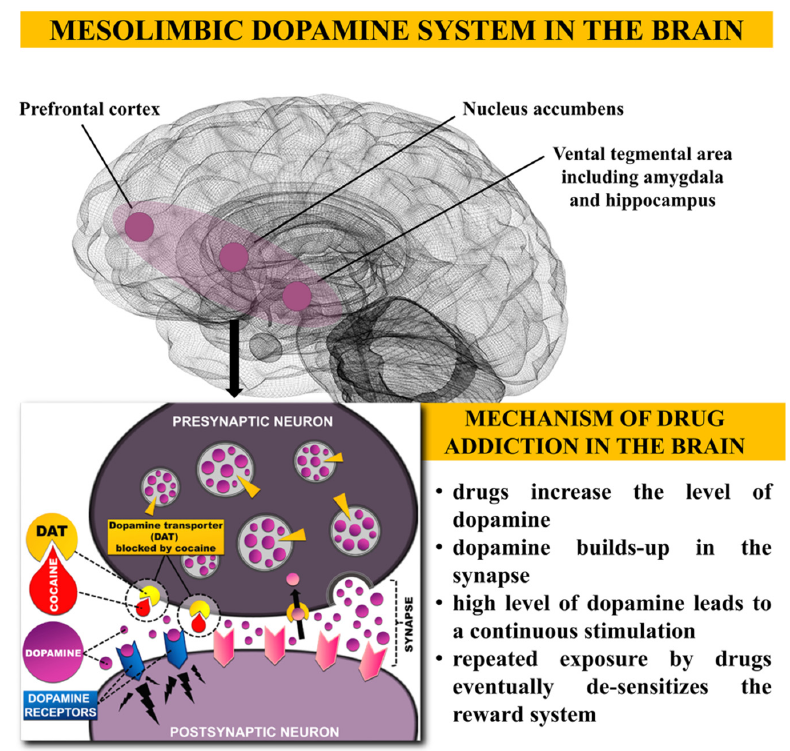
Figure 2. Model of drug addiction mechanism and dopamine projection in mesolimbic dopamine system: dopamine, drugs (stimulants, opioids), dopamine receptors, dopamine transporter (DAT). A schematic diagram illustrates the mesolimbic dopamine system in the brain and the dopamine neuronal role in drug addiction. Dopamine projections target the nucleus accumbens, prefrontal cortex, amygdala, and hippocampus. Direct administration of drugs and their systemic administration results in the release of large amounts of dopamine from dopamine neurons in the VTA, which is released into the nucleus accumbens and prefrontal cortex [77]. Reprinted with permission from Ref. [77]. 2021, NIDA Public Inquiries Team.